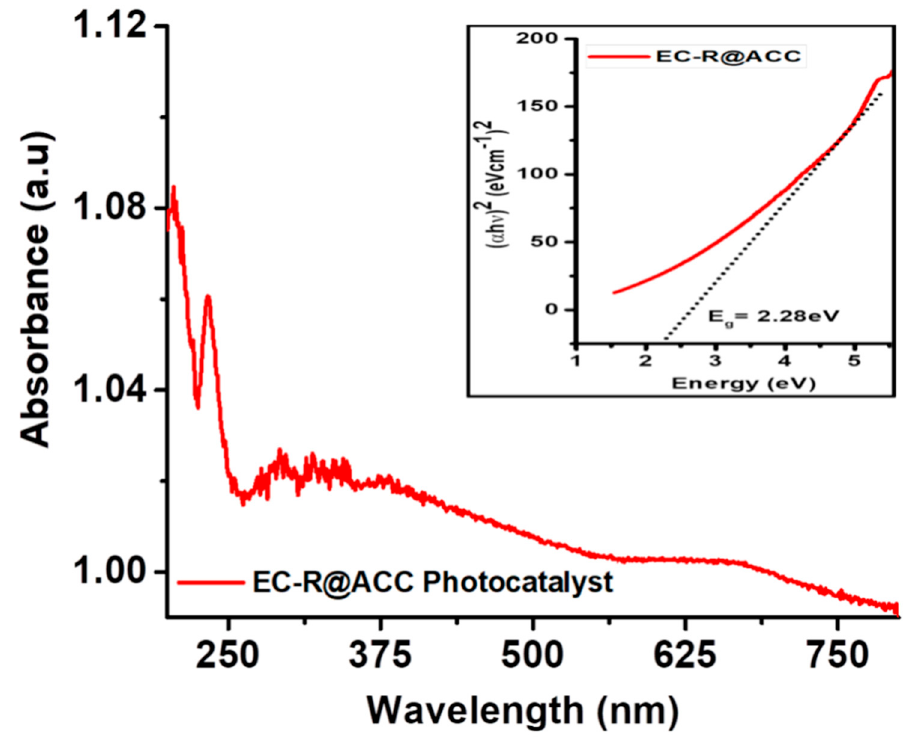
Figure 2. UV-Visible absorption spectra of the photocatalyst.